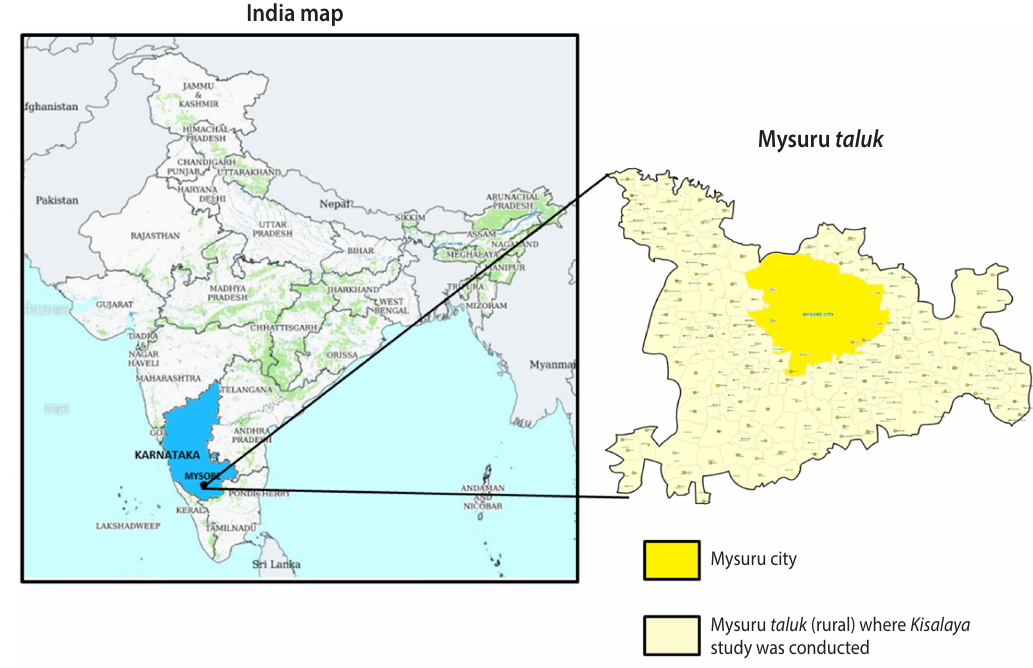
Figure 1. Picture depicting the Mysuru taluk rural area where the Kisalaya study was conducted. Source from: Government of India. Indian space research organization (ISRO) centres